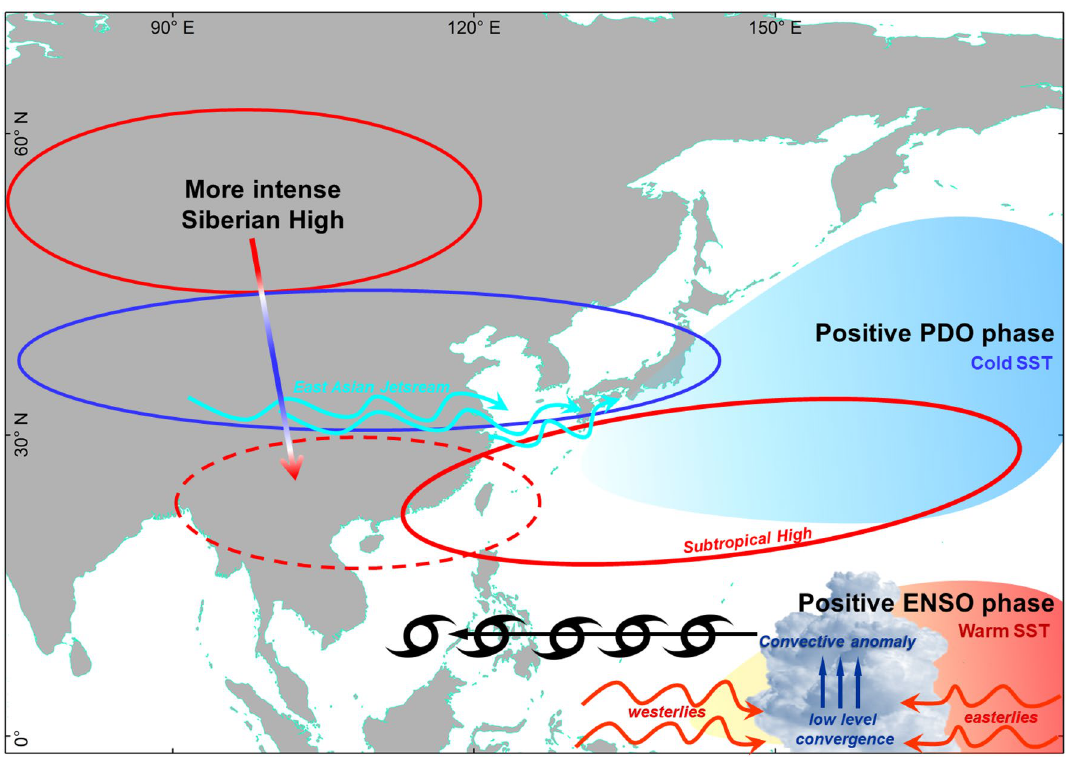
Figure 4. Influences to Christmas typhoons. A positive PDO phase is coincident with a positive ENSO phase, which is characterized by cold (warm) SST anomalies in the north (tropics). The anomalous low-level westerlies provide background cyclonic vorticity and converge with low-level easterlies leading to the formation of convective anomalies. The higher air-sea temperature difference results to more water vapor fluxes from the sea and reduced entrainment of dry air that enhances the convective anomalies. The westward extension of the WNP subtropical high directs the tropical cyclones toward the Philippines. Meanwhile, a more intense Siberian High corresponds to stronger subtropical jetstream and highlighted by its stronger teleconnection with a stalled high pressure system flanking over the mainland Southeast Asia and extending towards the northern Philippines. The schematic is drawn using Microsoft PowerPoint (https:// www. micro soft.